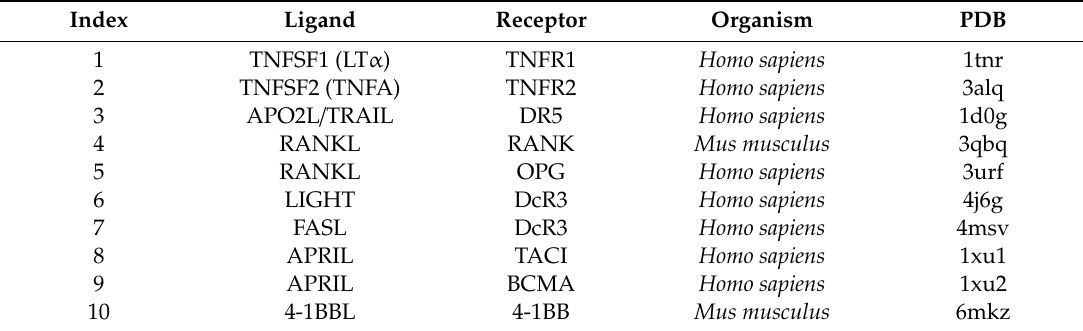
Table 1. The dataset of TNF ligands and receptors used in this